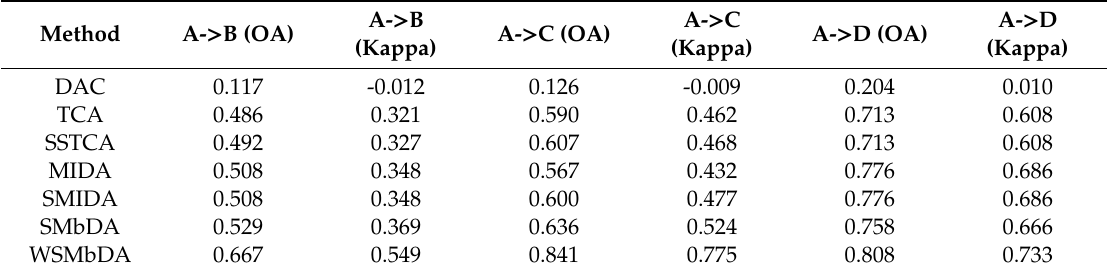
Table 2. Precision evaluation results in